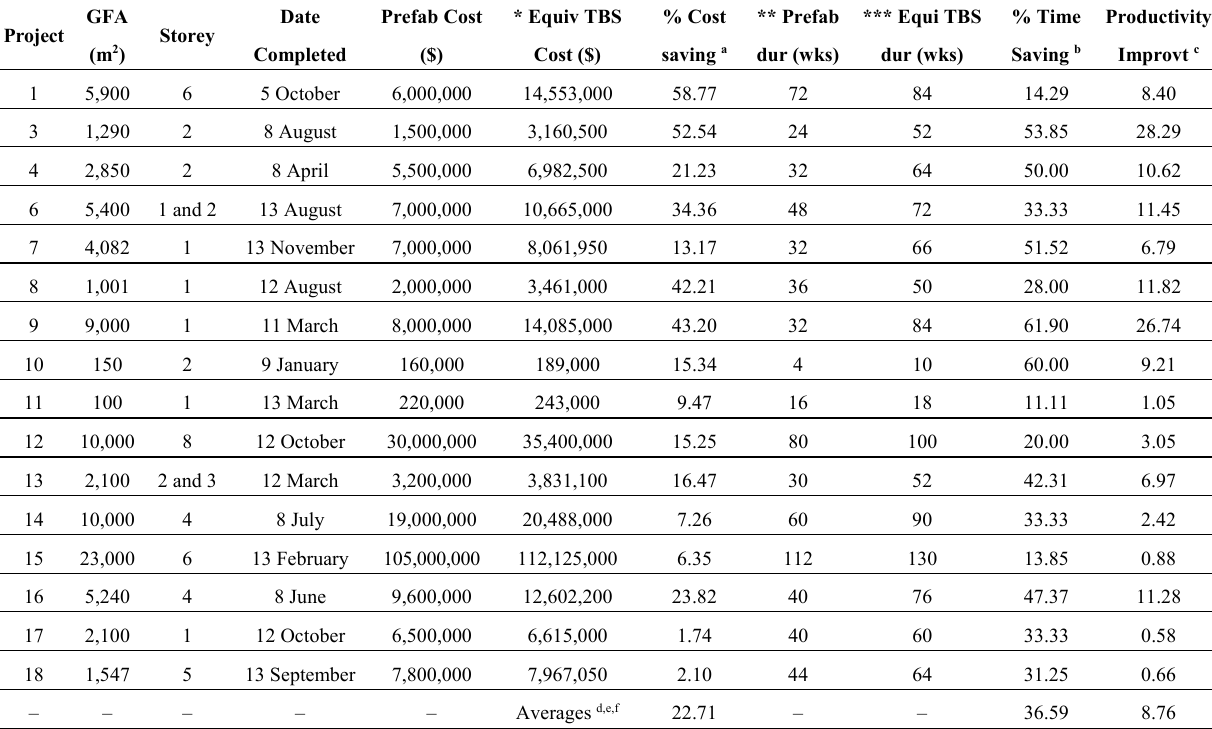
Table 1. Prefab marginal benefits (typical analysis for commercial building